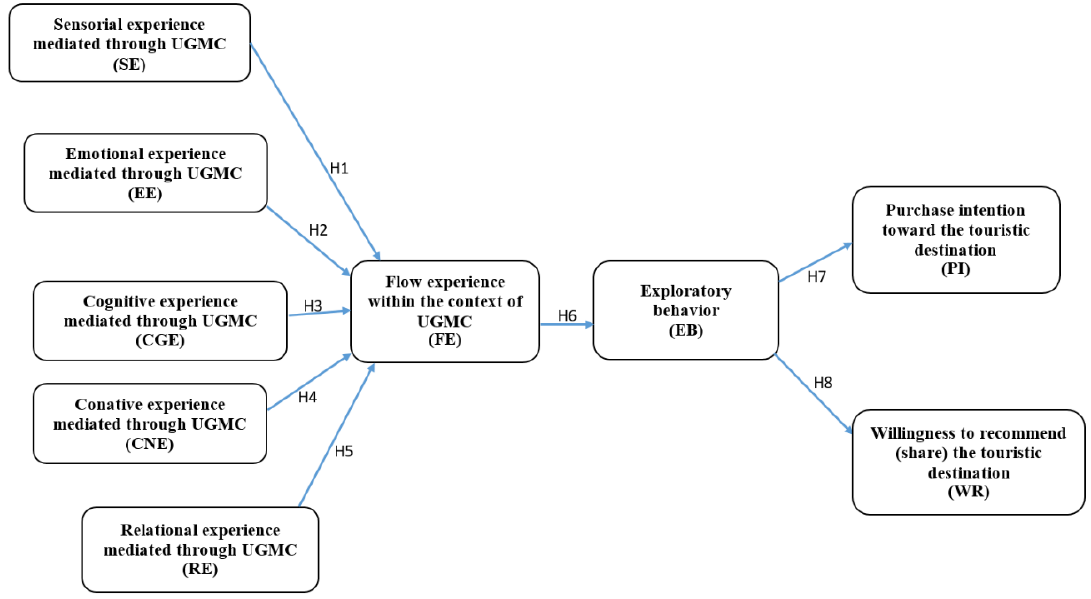
Figure 1. The conceptual model proposed.